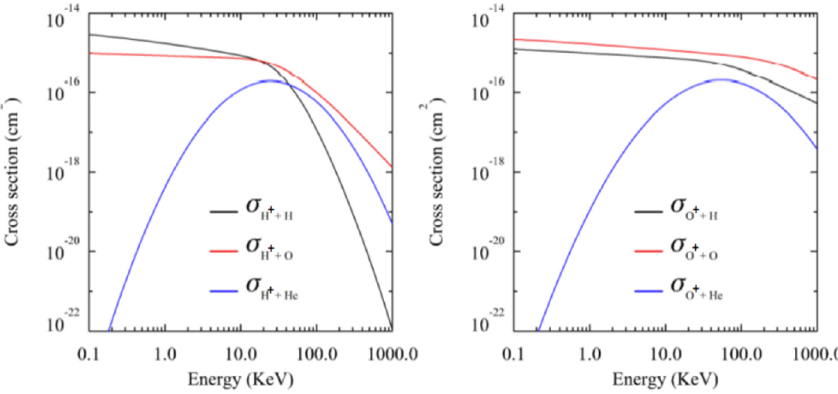
Figure 3. Cross section between ions (left: H + , right: O + ) and geocoronal